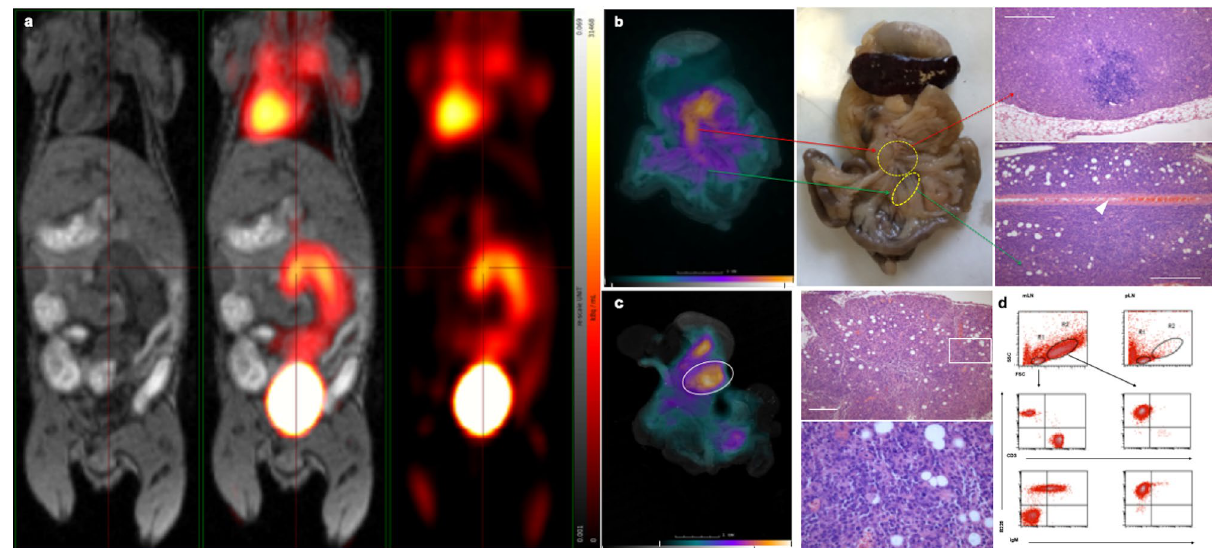
Figure 1. Molecular imaging results in advanced stage lymphoma-bearing mice. ( a ) PET/MR image in advanced stage: FDG-avid enlarged mesenteric lymph nodes are visible (horizontal plane, representative image). ( b ) Colour overlay of Cerenkov light emission (CLI) on the white light photograph of the intestinal preparation, with the spleen at the top of the image. FDG-avid lymphomatous regions and foci in the peritoneum and omentum are coloured orange. The H&E staining (upper right) depicts the diffuse infiltration of the omentum (scale bar = 200 µm), in the area marked by an ellipse on the CLI picture (scale bar = 200 µm). Lower-right image with high-power magnification shows lymphoblastic dominance corresponding to the area marked with rectangle (scale bar = 50 µm). Representative images from a cohort of mice with n = 3. ( c ) Ex-vivo CLI in late stage lymphoma: FDG-avid Bc-DLFL.1 lymphoma foci with H&E staining in mesenteric lymph node (top) and mesenterium (bottom) CLI (left) and, Stereomicroscopic picture of the intestinal preparation (middle), Histology (right): the red arrow shows that the upper encircled area in the stereomicroscopic picture emits Cerenkov light and corresponds to the mesenteric lymph node complex, containing a massive lymphoma infiltrate demonstrated on the top right image (connected by dashed red arrow). The bottom green arrow connects one branch of the mesentery with lesser Cerenkov signal intensity (marked with ellipse), with an extensive lymphoma infiltrate surrounding the mesenteric artery (arrowhead). Scale bar = 200 µm. Representative images from a cohort of mice with n = 3. ( d ) Flow cytometric analysis of enlarged mesenteric lymph nodes (mLN) reveals residual small-sized (in R1 gate) CD3-positive T cells and B220-positive B cells (left, middle), latter cells mostly co-expressing IgM (left, bottom), and large number of blast-sized cells (in R2 gate) displaying B220 B-cell marker and absence of CD3-positive cells (right, middle), but lacking surface IgM and CD3 (right, bottom). Lymphocytes from peripheral lymph nodes (pLN) do not contain a distinguishable blast population within the R2 gate (right, top). Representative images from a cohort of mice with n =